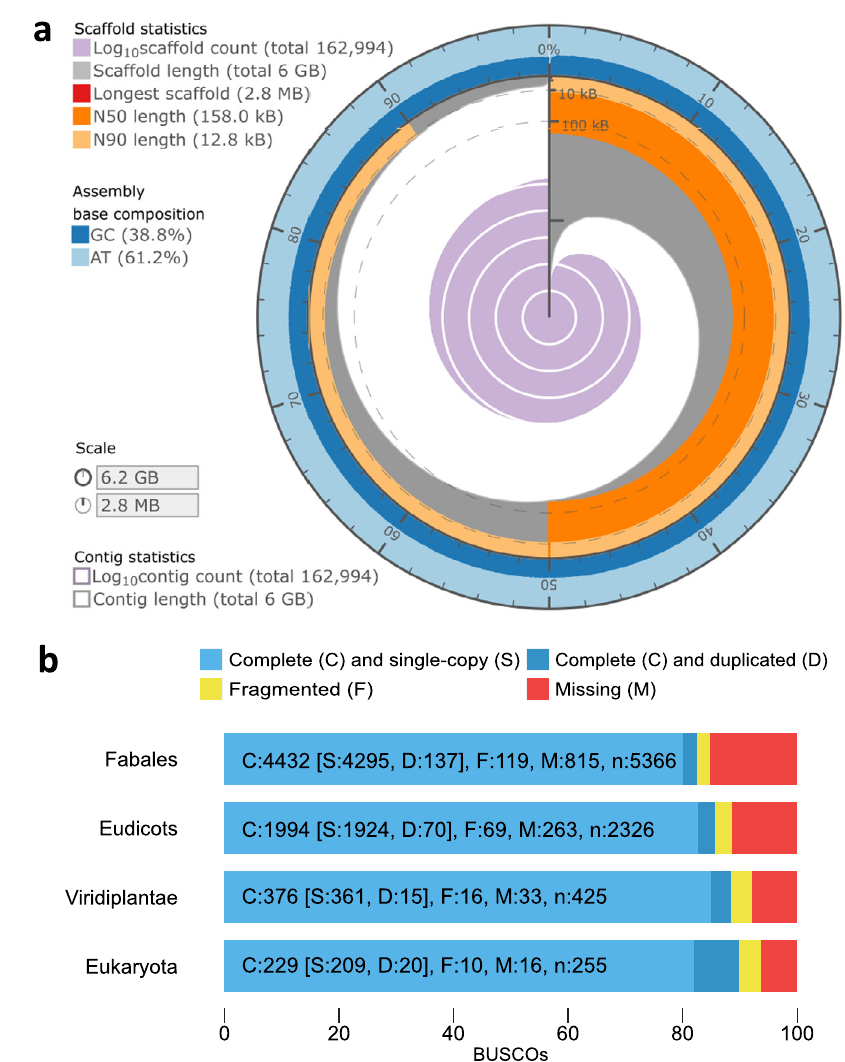
Fig.1|Assemblybenchmarking.a AssemblystatisticsfortheLS007long-readassembly,visualisedusingassemblystats 95 . b BUSCO(v.4.0.4)assessmentsofthe L.sativus LS007 genome assembly against the Fabales, Eudicots, Viridiplantae and Eukaryota datasets. Source data are provided as a Source Data fi le.